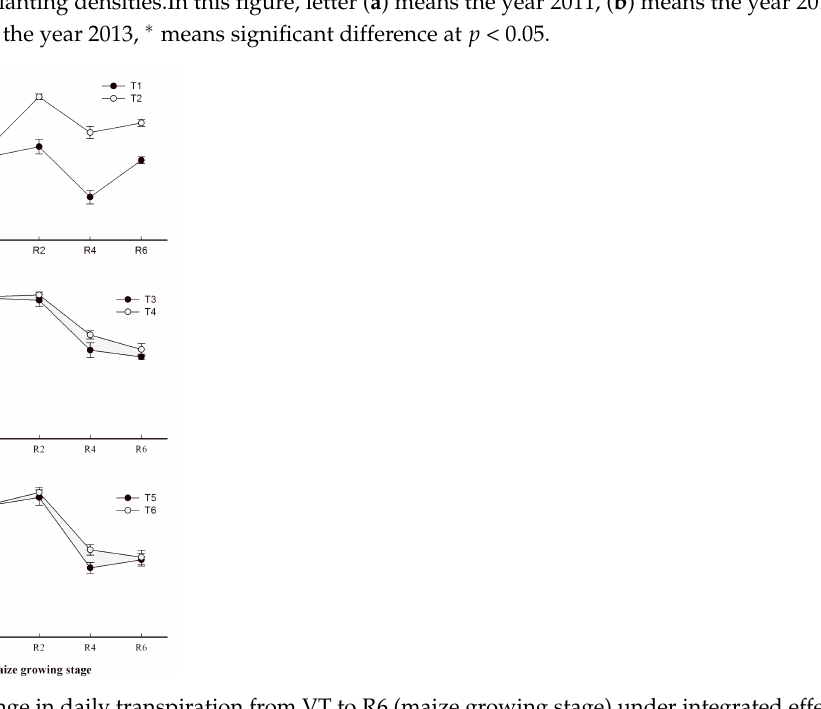
Figure 8. Change in daily transpiration from VT to R6 (maize growing stage) under integrated effect of organic manure and planting densities. In the two figures above, letter ( a ) means the year 2011, ( b ) means the year 2012 and ( c ) means the year